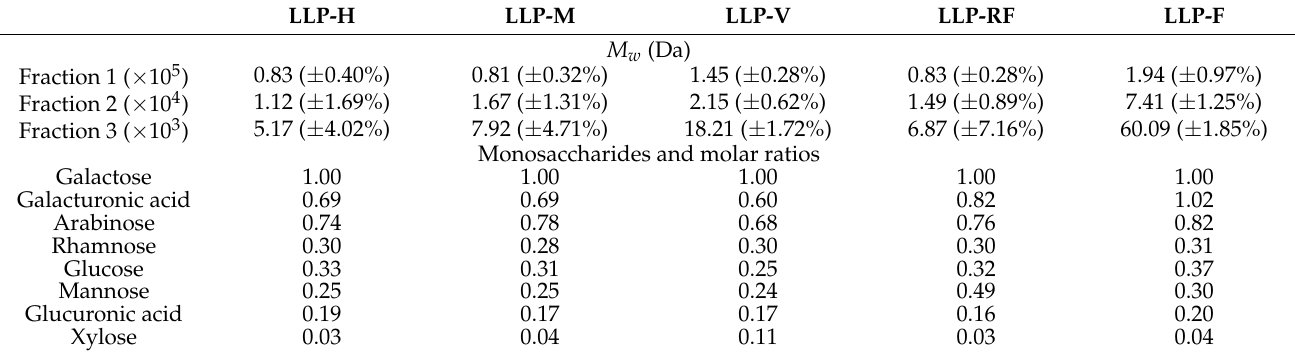
Table 2. Molecular weight ( M w ) and constituent monosaccharides of